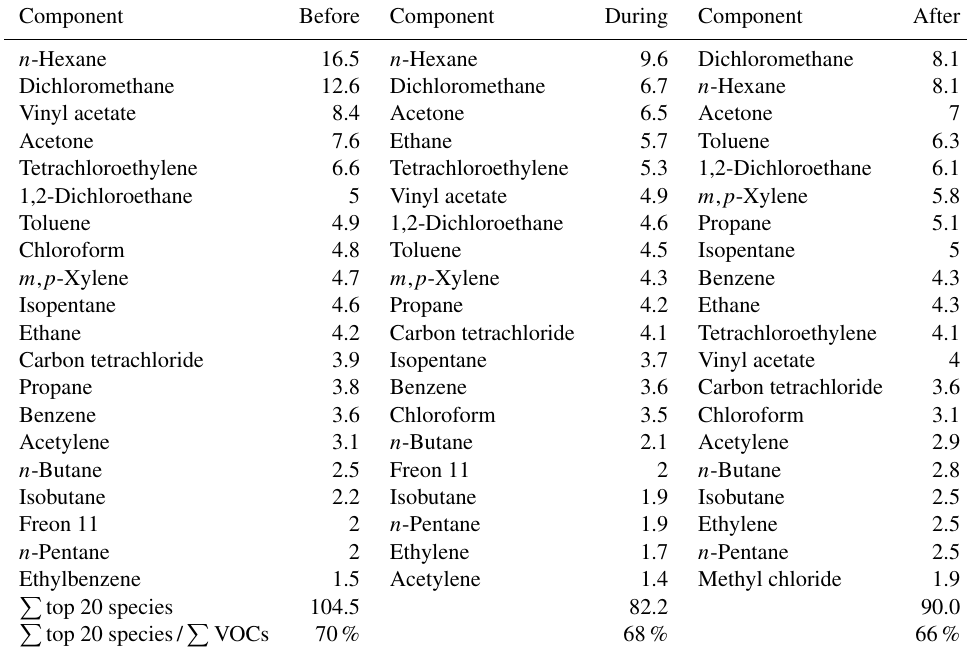
Table 1. Concentrations of the 20 most abundant species in Zhengzhou (unit: µgm − 3 ). Component Before Component During Component After n